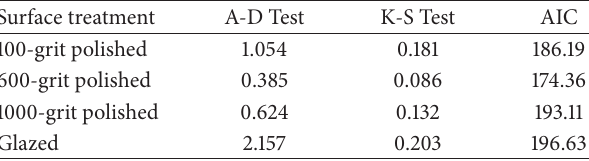
Table 2: Goodness-of-fit test results for Weibull distribution func- tion of four different groups (polished with 100-grit, 600-grit, 1000- grit, and glazed